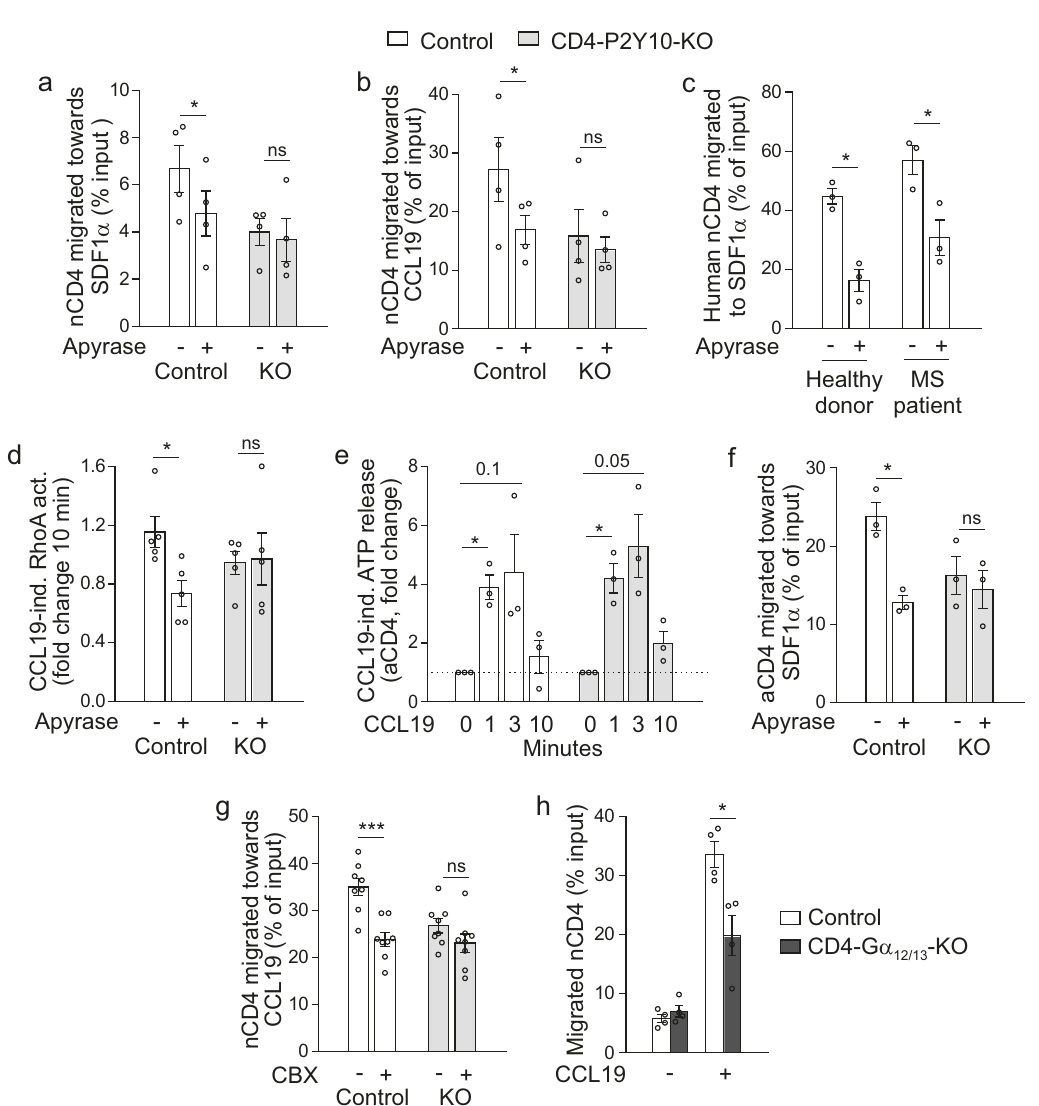
Fig. 5 LysoPS and ATP enhance RhoA activity in a P2Y10-dependent manner, and are released in response to chemokine stimulation. Changes in the levels of active, GTP-bound RhoA in nCD4 after stimulation with 1 μ M S1P or LPA ( a ), 1 μ M LysoPS 18:0 and 18:1 ( b ; *** p < 0.001), or 10 μ M ATP ( c ; ** p = 0.005) ( n = 4). d ATP (10 μ M)-induced changes in IP1 production in nCD4 ( n = 6 – 7; * p = 0.030). e ATP (10 μ M)-induced changes in cAMP levels in nCD4 ( n = 4, isoprenaline (Isopr.) 1 μ M as positive control). Calcium mobilization in empty vector (EV)- or P2Y10-transfected COS-1 cells in response to different concentrations of ATP and ADP: f original luminescence units (LU) from one exemplary experiment (** p = 0.007 (10 µ M), 0.003 (30 µ M)); g ratio of luminescence units in P2Y10- vs. EV-transfected cells in 4 – 5 independent experiments (* p = 0.012, 0.022, 0.037 0.016 (from left to right). h CCL19-induced changes of ATP levels in supernatants of nCD4 ( n = 5 – 8; * p = 0.018 (contr/3 min), 0.039 (KO/1 min), 0.031 (KO/3 min); ** p = 0.002 (contr/1 min)). LysoPS species 18:0 ( i , j ) and 18:1 ( k ) were determined by LC-MS/MS in the supernatant ( i ) or lysates ( j , k ) of CCL19-treated CD4 T cells ( n = 3). Data are means± SEM; comparisons between genotypes were performed using two-tailed unpaired Student ’ s t- test ( a – e ), two-way ANOVA with Tukey ’ s multiple comparisons test ( f ) or two-tailed one sample T test against 1 ( g , h ). n , number of mice per group ( a – e , h – l ) or independent in vitro